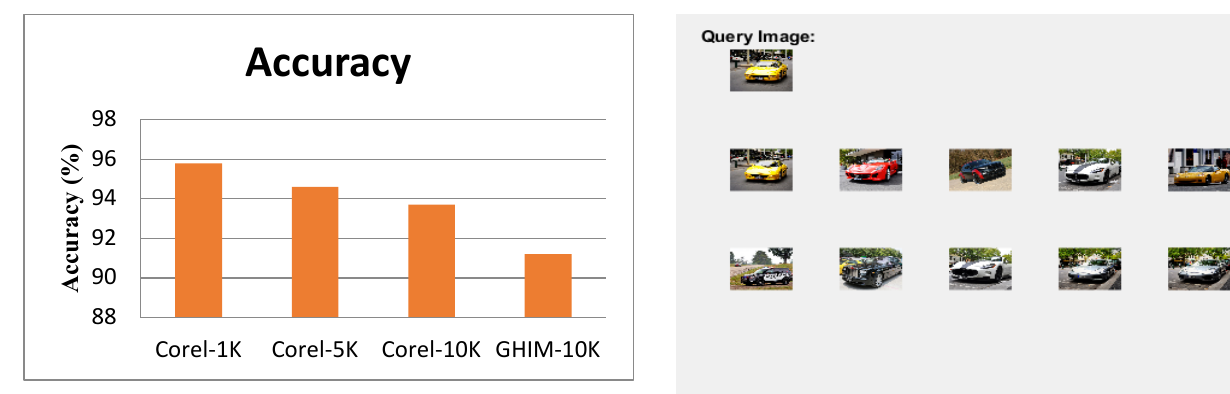
Figure 15. Top 10 images retrieved by the proposed